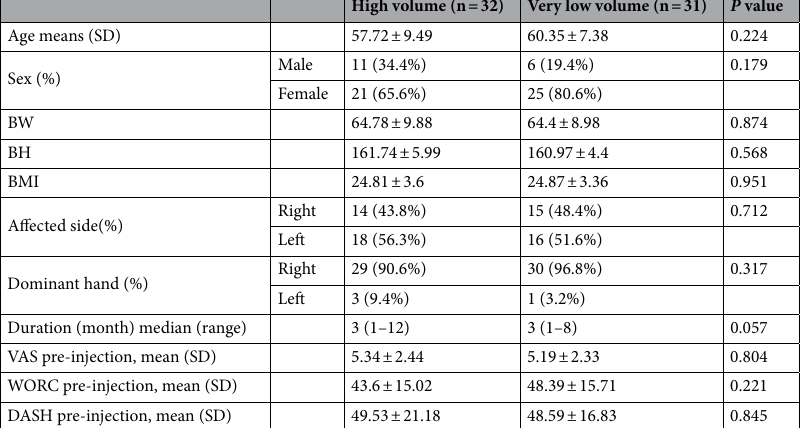
Table 1. Demographic data detail of age, sex, dominant side, affected side, duration, VAS, WORC and DASH by treatment group.